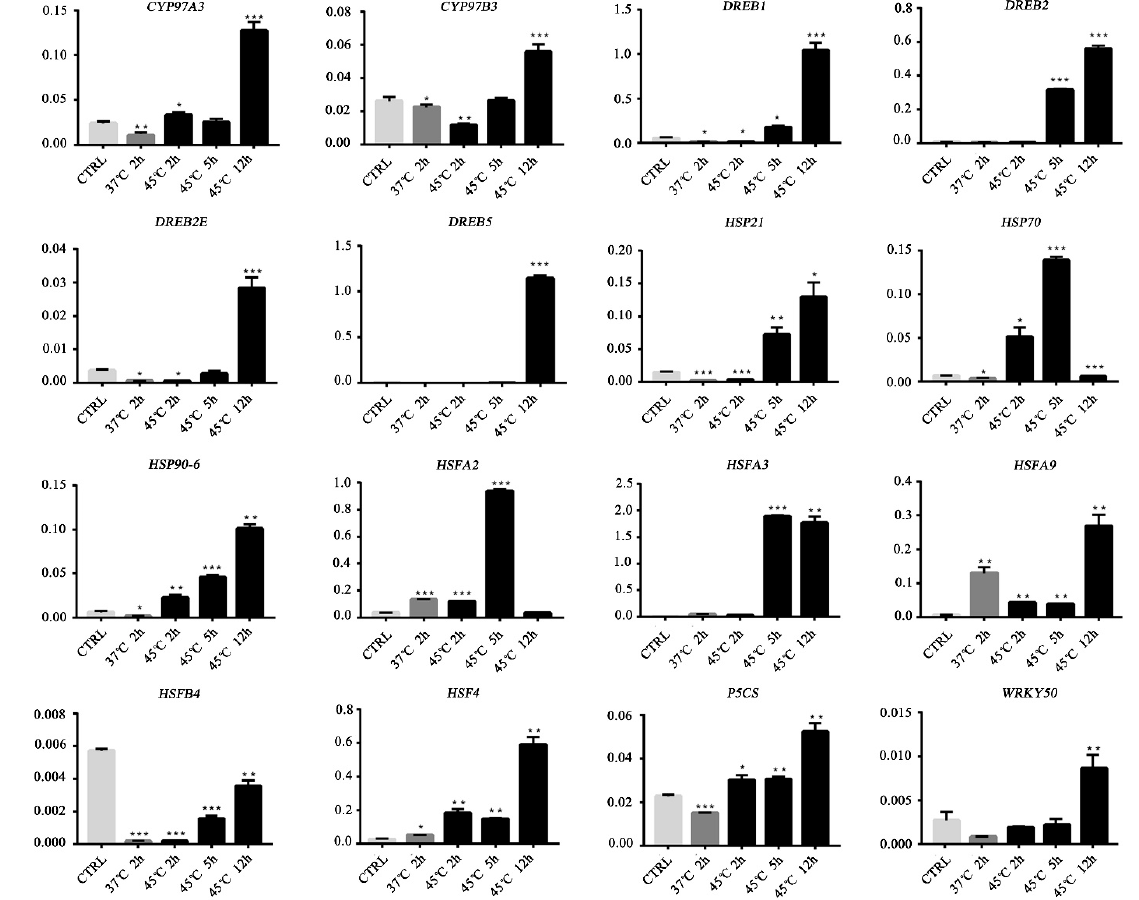
Figure 9. Quantitative qRT-PCR of 16 candidate genes ( CYP97A3, CYP97B3 , DREB1 , DREB2 , DREB2E , DREB5 , HSP21 , HSP70 , HSP90-6 , HSF4 , HSFA2 , HSFA3 , HSFA9 , HSFB4 , and WRKY50 ). Error bars represent standard errors. Bars are means ± SD; n = 3. * p < 0.05; ** p < 0.01; *** p < 0.001.